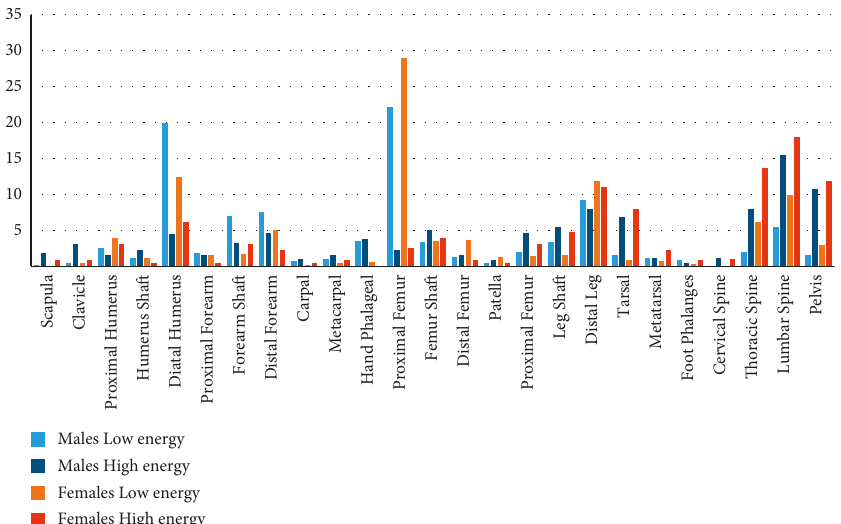
Figure 5: Fractures distributions according to gender and injury energy.